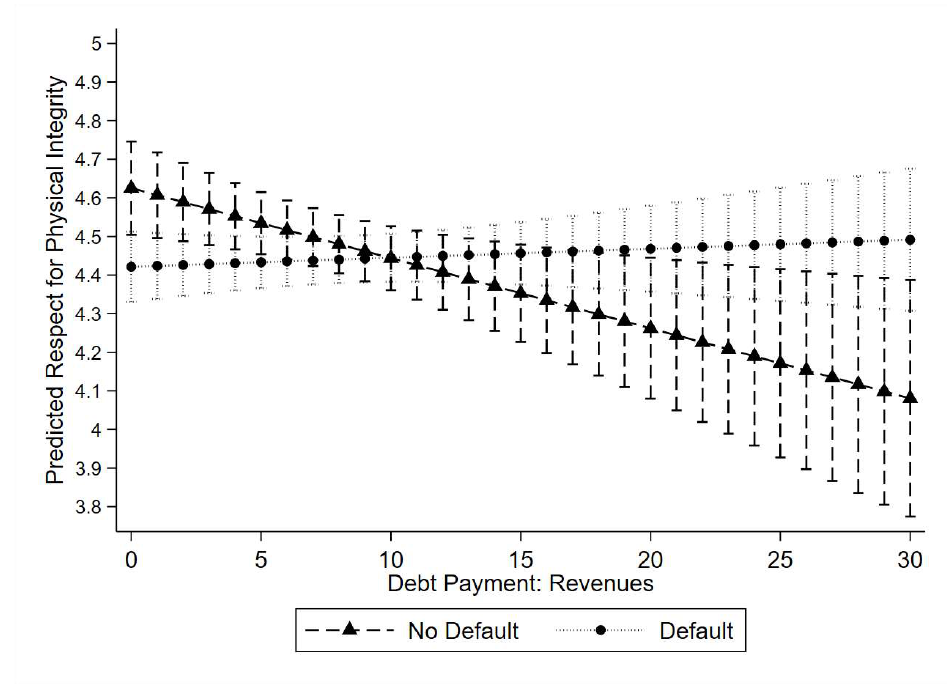
Figure 4. Marginal Effects of Default and Non-Default at Increasing Debt:Revenues.